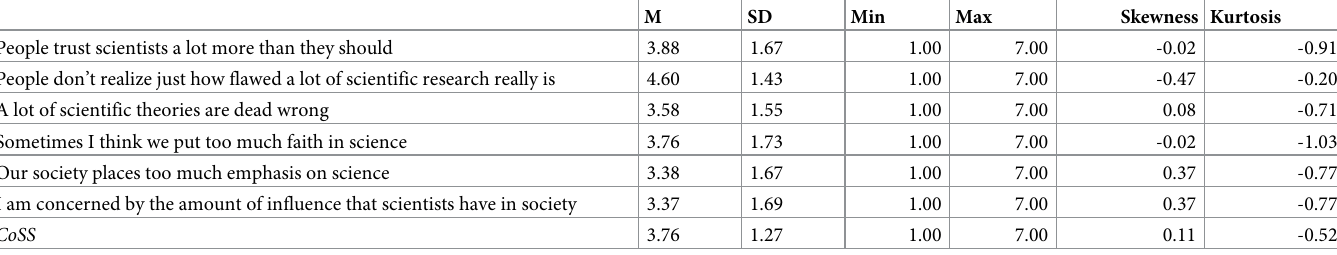
Table 2. Descriptive statistics of the items on the CoSS–Study